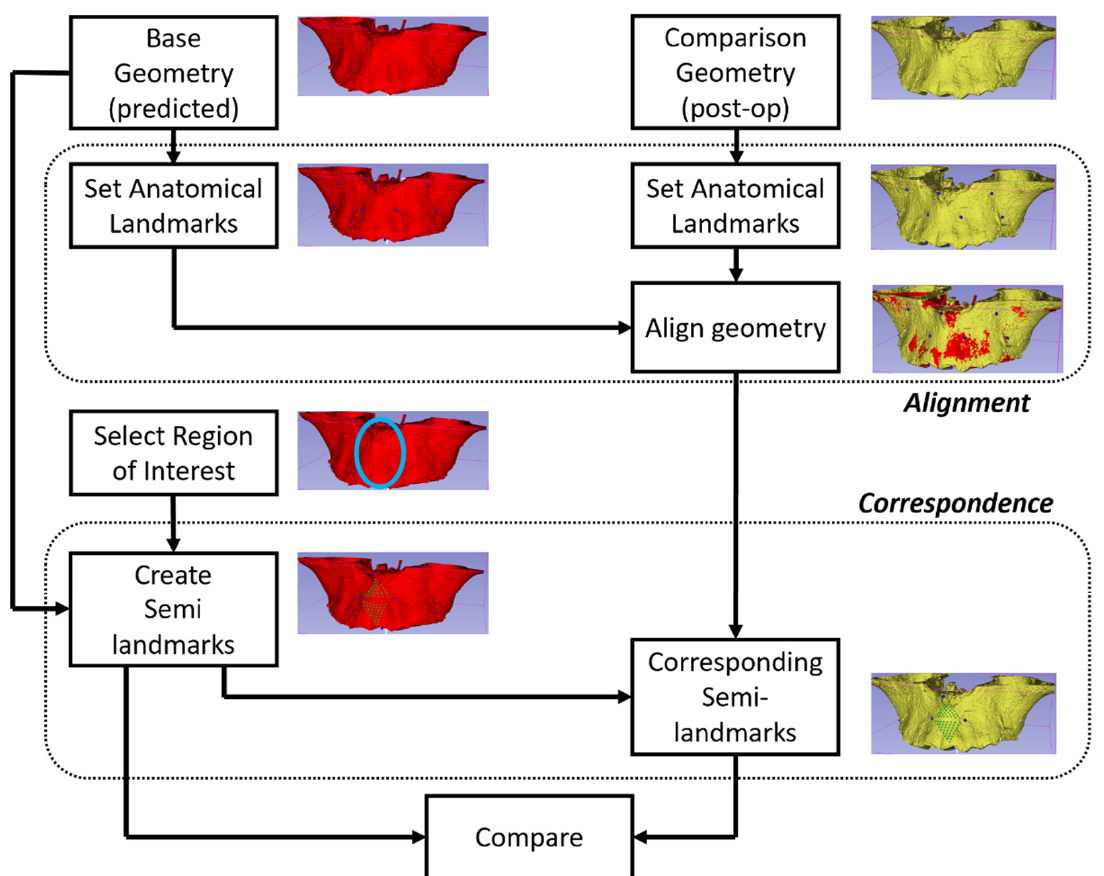
Figure 7. Prediction analysis procedure.